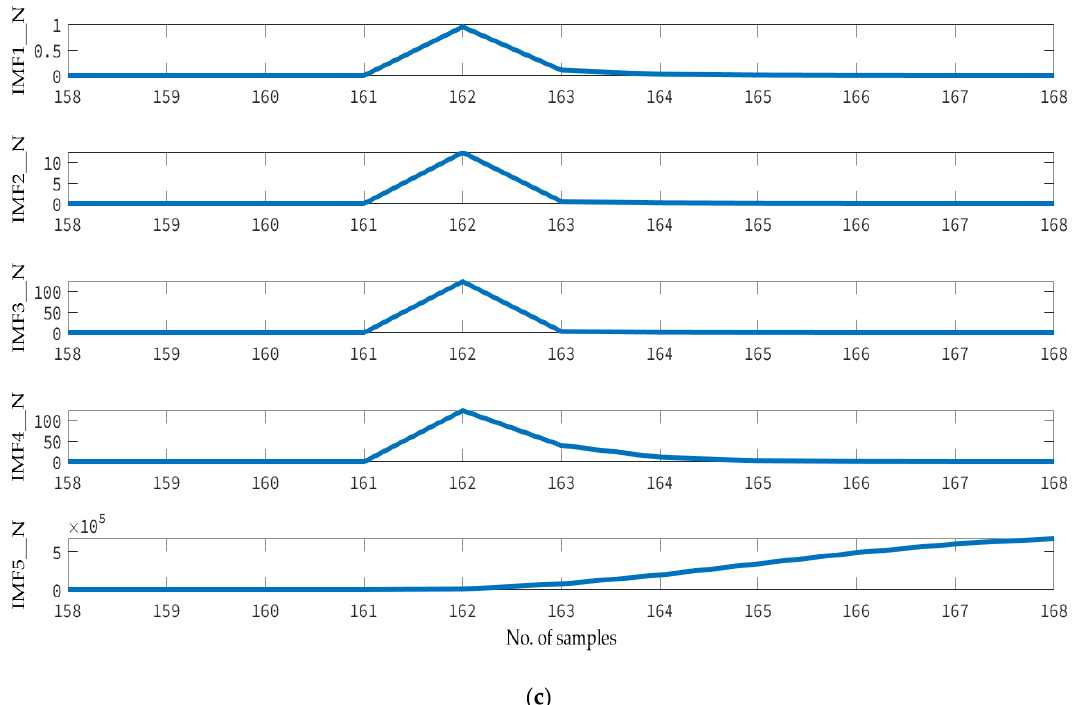
Figure 4. Five VMD IMFs were detected by a relay placed on bus-5 during the single-line to ground fault at phase A. ( a ) IMF obtained from the zero-sequence component of the voltage signal; ( b ) IMF obtained from the positive-sequence component of the voltage signal; ( c ) IMF obtained from the negative-sequence component of the voltage signal.